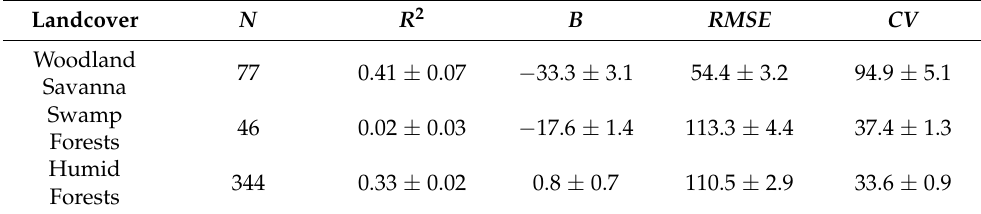
Table 1. Relationships between field- and map-derived plots’ aboveground biomass by land cover class.